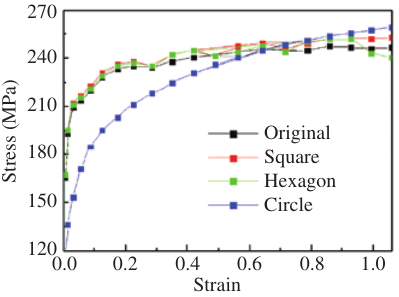
Figure 3 Stress-strain behaviors of SiCp/Al composites with different particle